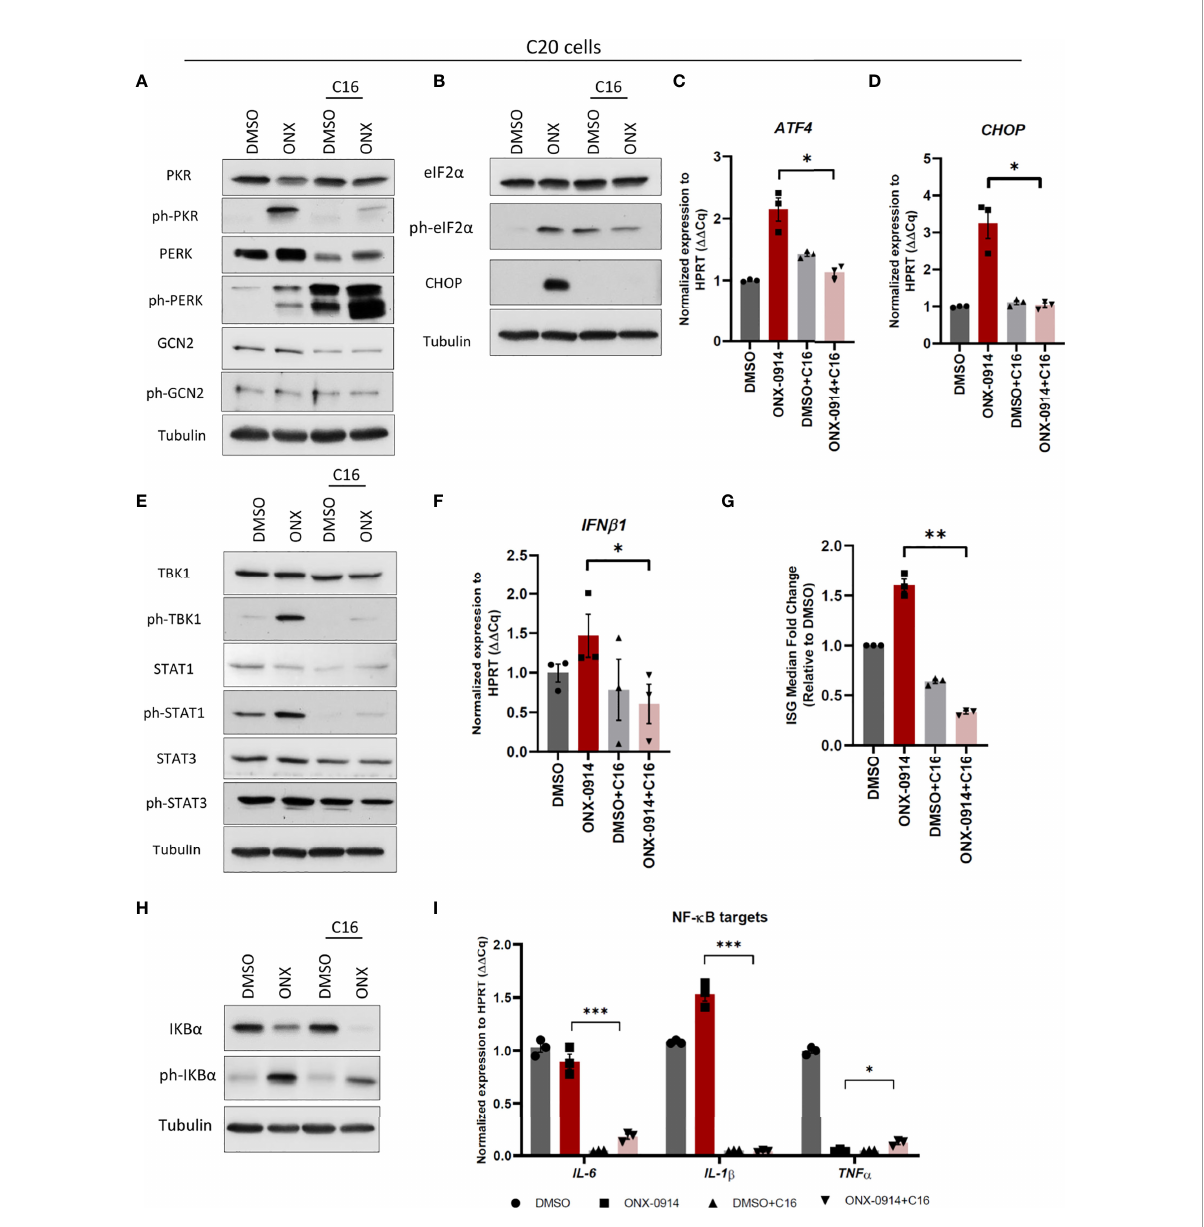
FIGURE 6 Protein kinase R (PKR) activation controls type I IFN response and NF- k B pathway activation in C20 cells following ONX-0914 treatment. C20 cells were subjected to treatment with 200nM ONX-0914 or DMSO control for 24h following pre-treatment with 1µM PKR inhibitor C16 for 2h. (A, B) Western blot analysis of UPR/ISR proteins in C20 cells following treatments. (C, D) Quantitative reverse transcription PCR (RT-PCR) analysis of ATF4 (C) and CHOP (D) mRNA levels in C20 cells following treatments. (E) Western blot analysis of type I IFN response proteins in C20 cells following treatments. (F) Quantitative RT-PCR analysis of IFN b 1 mRNA level in C20 cells following treatments. (G) IFN score calculated by ISG median fold change in C20 cells following treatments. (H) Western blot analysis of NF- k B pathway proteins in C20 cells